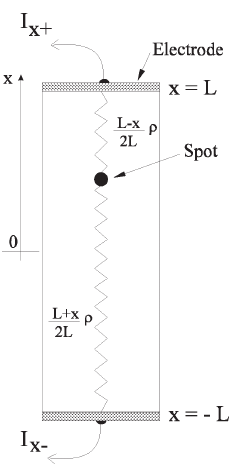
Fig. 1. Model of a one dimensional detector.